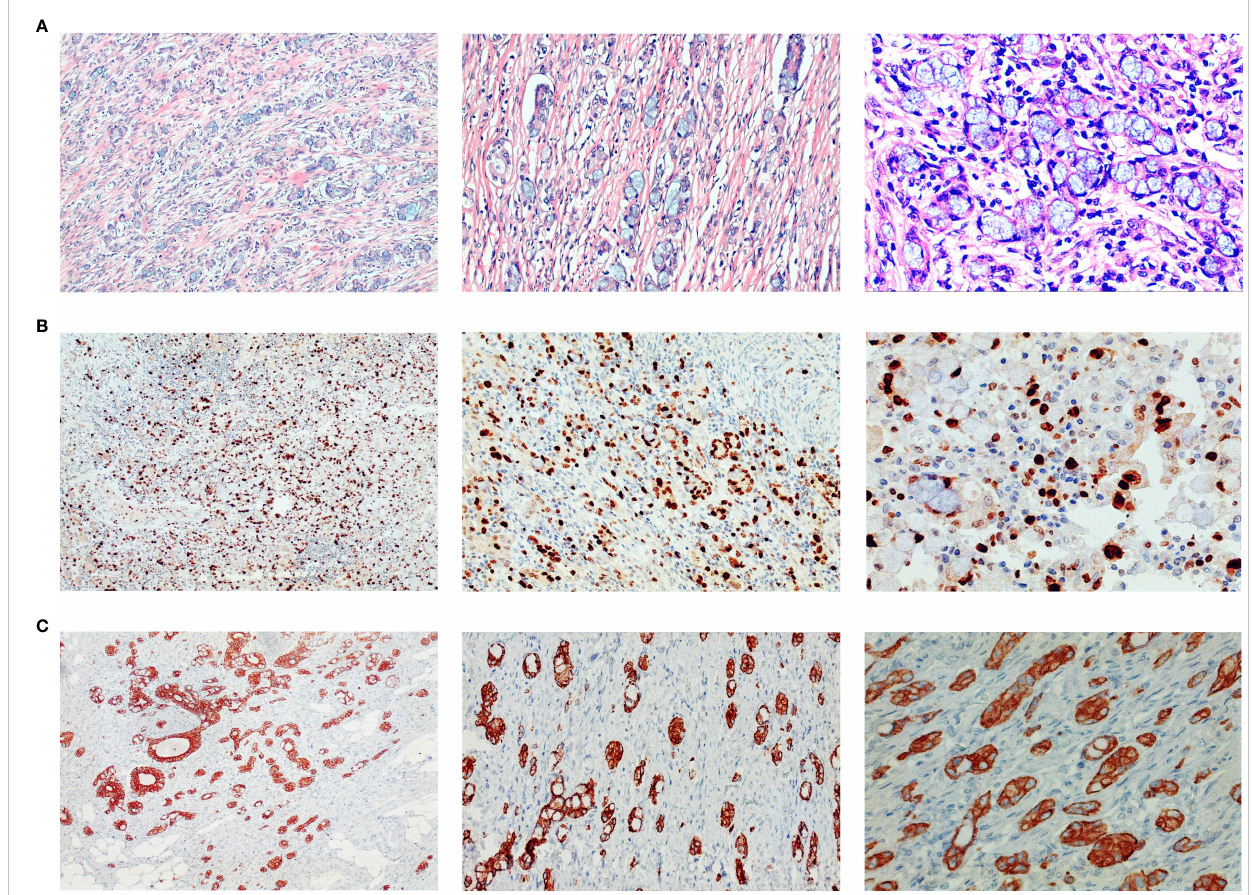
FIGURE 4 Histopathology of surgical specimens. Postoperative pathology showed signet ring cell carcinoma among moderately-to-poorly differentiated AC in the right colon. Hematoxylin and eosin staining showed signet-ring cell carcinoma (A) , and further immunohistochemistry staining showed ki-67 (>80% +) (B) , and CK8 (+) (C) . Pictures were magni fi ed ×100 on the left, ×200 in the middle, and ×400 on the